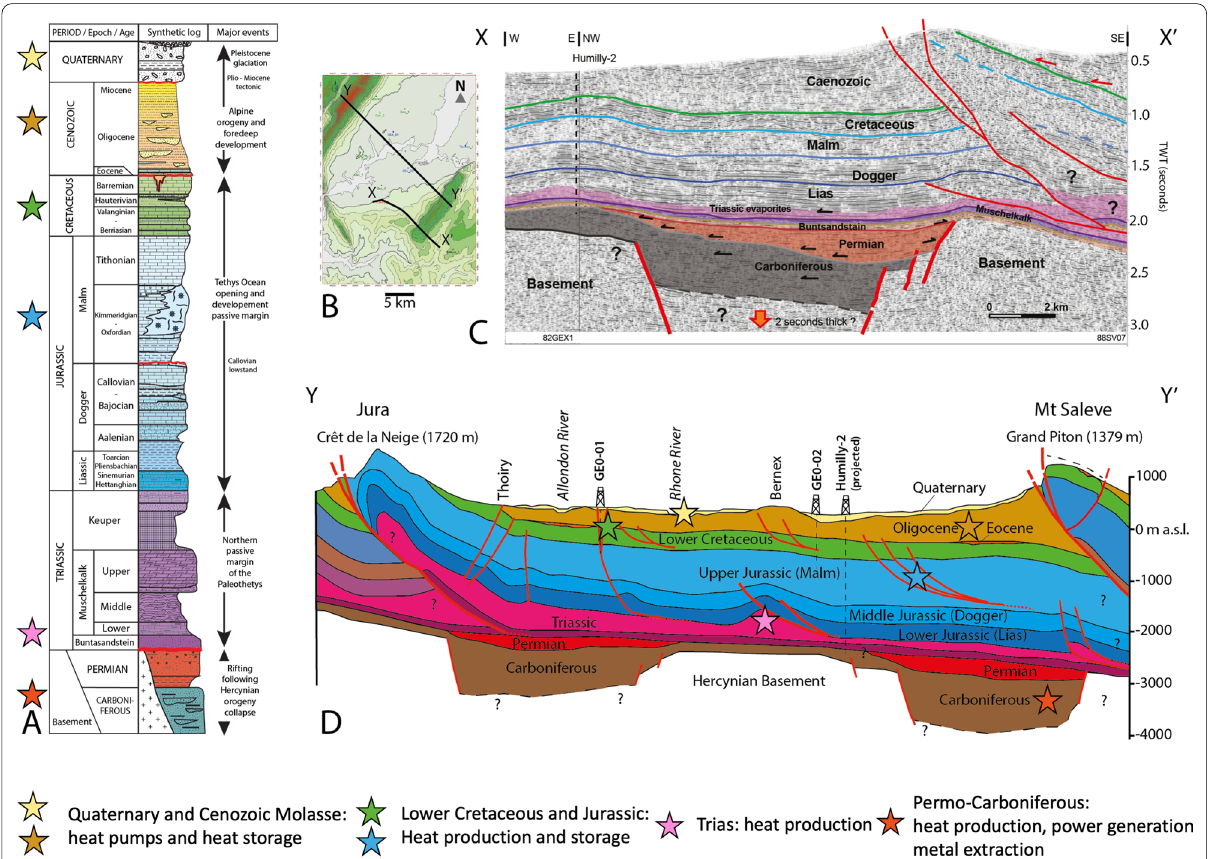
Fig. 2 A stratigraphic log of the Geneva Basin and indication of the main geothermal targets; B Map across the Geneva Basin showing the traces of the seismic line in panel C and of the geologic cross-section in D ; C Seismic profile over the SW sector of the Geneva Basin ( (modified from Moscariello, (2019)); D Cross-section cutting through the GB (modified from Moscariello, (2019) indicating the main geothermal